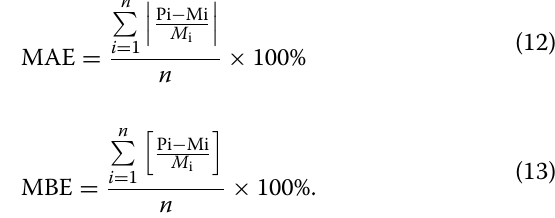
Similarly, the accuracy of the proposed models (GEP, MISO-ANN, and MLR) for predicting HHV is also evalu- ated as presented in Fig. 10. All the predicted data points using the MISO-ANN fall within the 3% error lines for both the testing and validation data points. The majority of the predicted data points by GEP and MLR models fall outside the error lines in Fig. 10. As a result of the pres- ence of the data points predicted using the MISO-ANN model within the error band, the performance of the MISO-ANN is excellent as the R 2 of 0.999 is obtained for